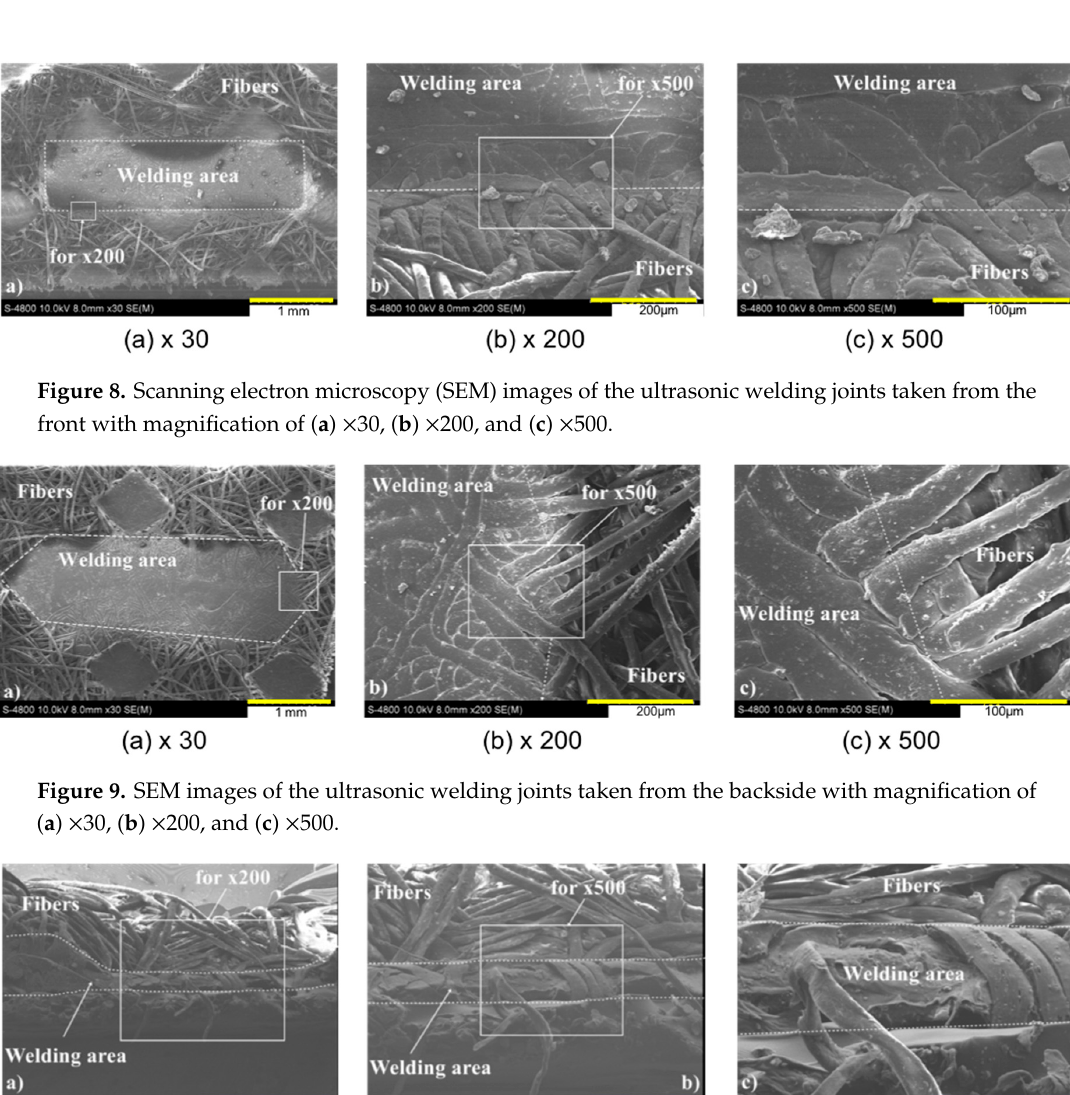
8 of 12 Figure 7. Nonwoven fabric after ultrasonic welding of No. 1 case. ( a ) Front side view, ( b ) Back side view. It is well known that a mechanical vibration of ultrasonic frequency, with specific amplitude and mechanical force, from the roller can create heat at the interface of two fabrics. The heat is increased rapidly in the case that either the force increases or the welding speed decreases. As a result, the fabrics at the interface melt and solidify quickly. In order to investigate the welding quality, SEM images were taken at the boundary between the welding area and the base metal (i.e., fabric fibers) of the welding joints, both of the front side (Figure 8) and of the backside (Figure 9). Figure 8a shows the entire welding joint of the one-line engraving taken from the front view. The boundary between the welding area and the base fabric is relatively clear. The fibers in the welding area are compressed lower than the fabric surface. Welding defects can be found in the welding zone, since the base fabric is not of a homogenous material. Some fabric fibers are totally melted, but others still exist (as incompletely melted). This can be explained by the fact that the thickness of the fabrics is not uniform, and heat is not generated equally over the welding area. Figure 8b,c presents the structure at the edge of the welding boundary, where half of